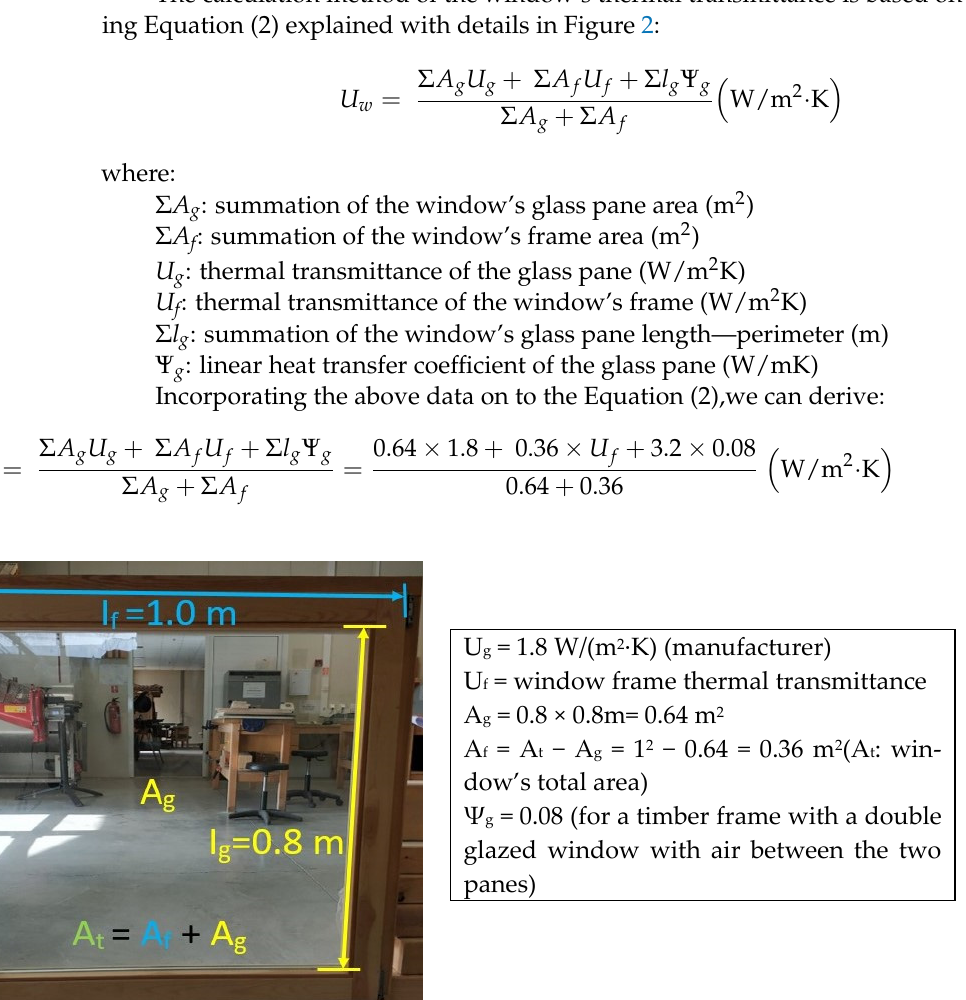
Figure 1. Types of laminated wood; fir in surface layers and meranti in core (FMF - a ) and meranti